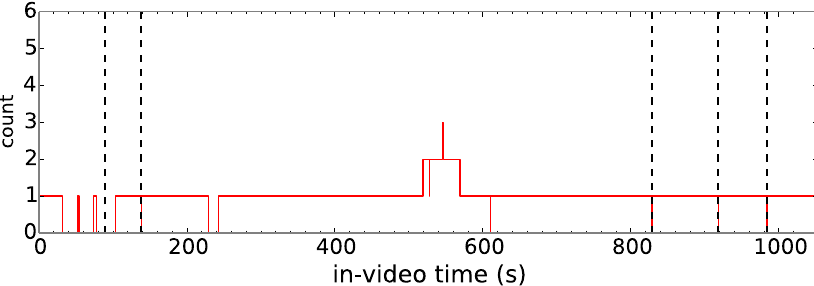
FIG. 2. Time series indicating the number of times student 3 accessed a given second in video 15 during that student ’ s 5th accessing session ( A ijkt with i ¼ 3 , j ¼ 15 , k ¼ 5 ). In this session, student 3 accesses most of the video once while accessing 519 – 567 s multiple